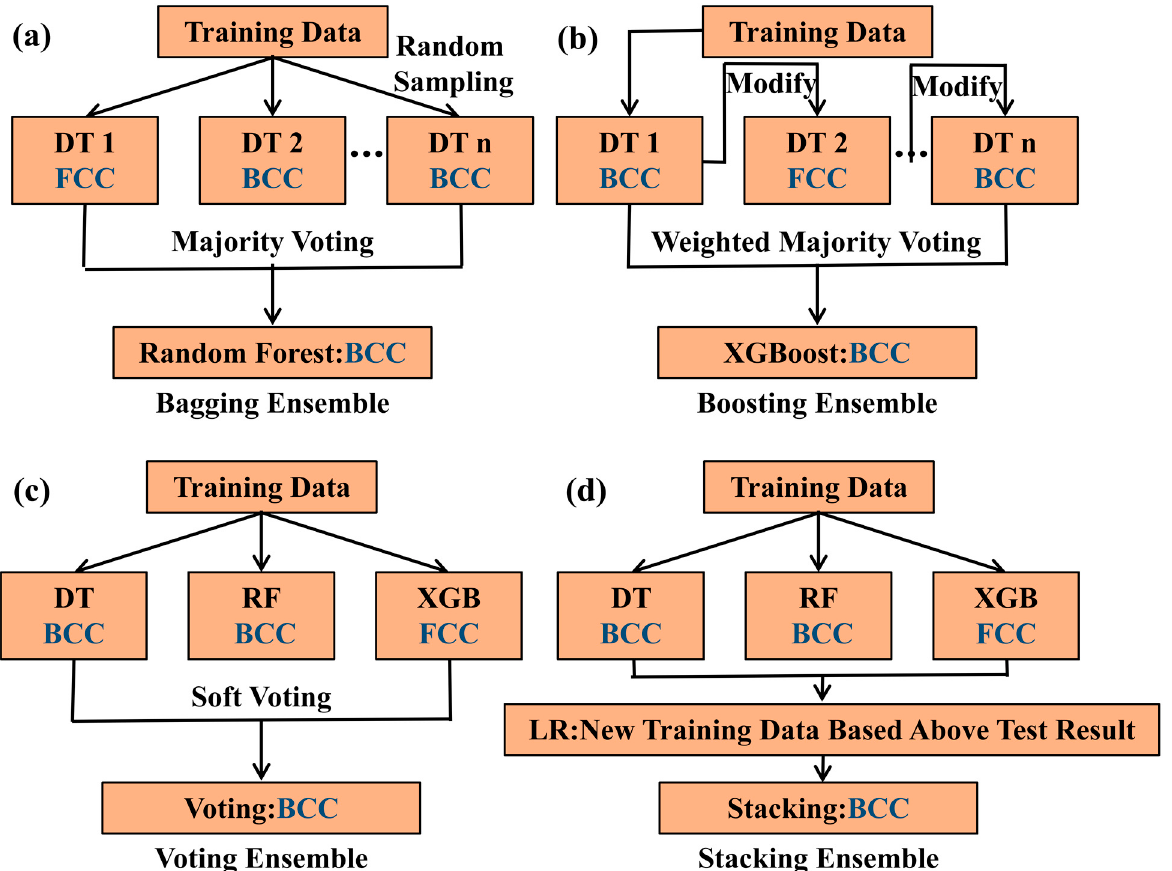
Figure 1. ( a ) Working principle of Random Forest algorithm, ( b ) working principle of XGBoost algorithm, ( c ) working principle of Voting algorithm, and ( d ) working principle of Stacking algorithm.